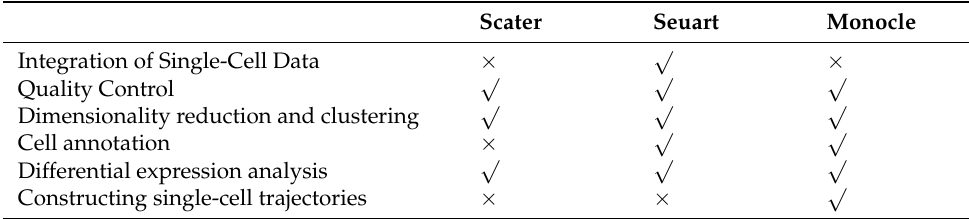
Table 3. The functions of the three mainstream r packages. Scater Seuart